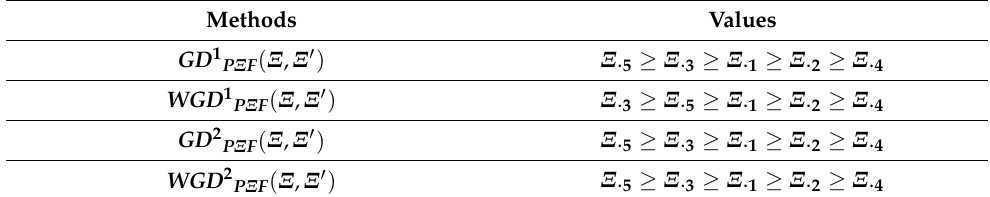
Table 5. Contained ranking analysis.